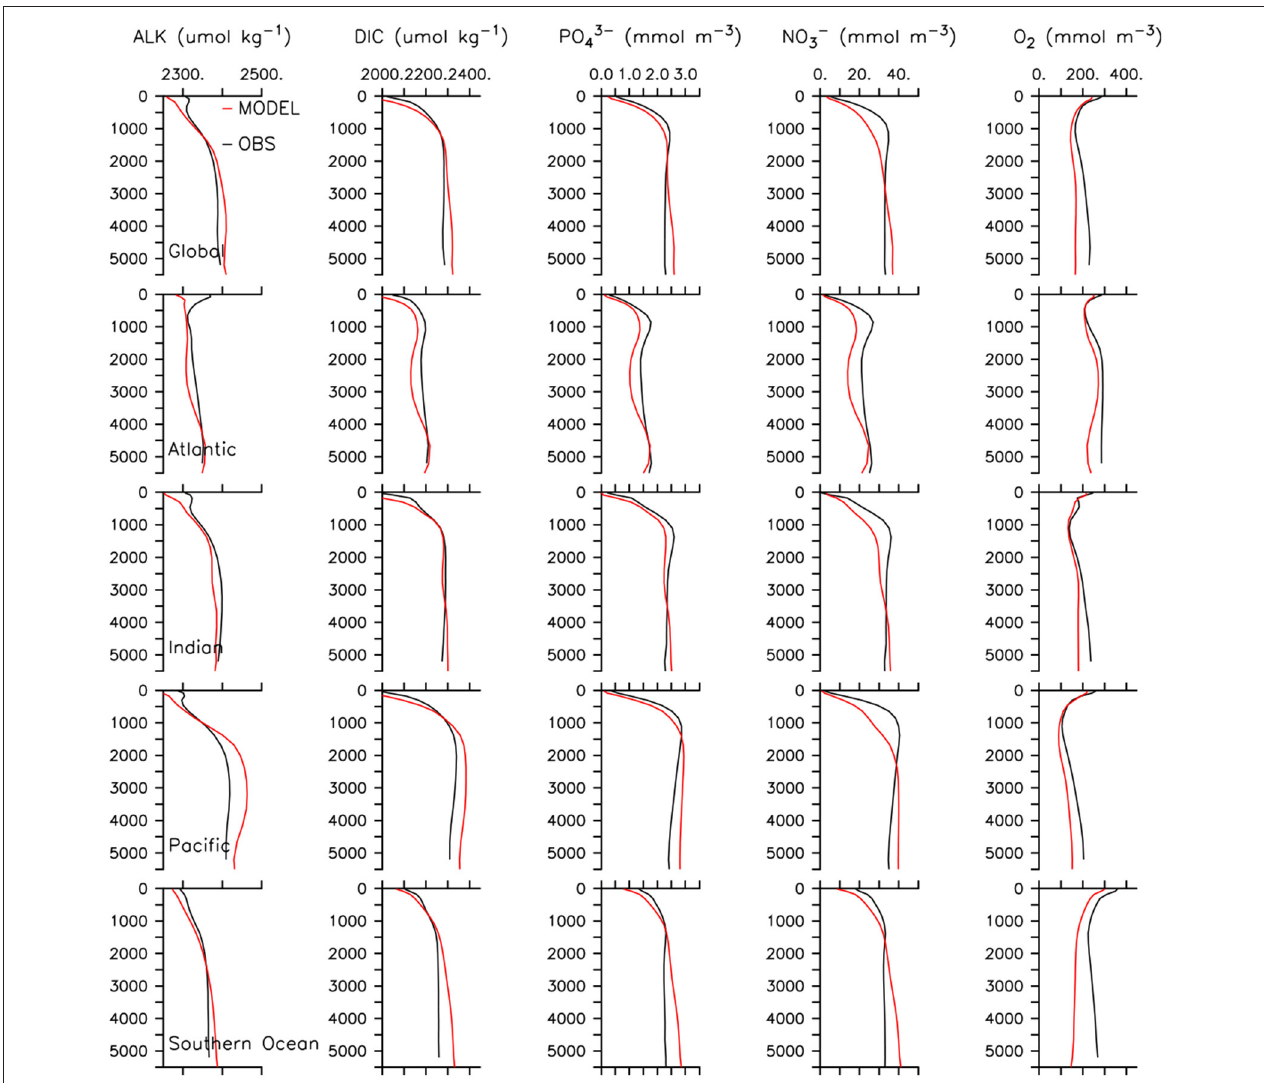
FIGURE 1 | Model global and basin-average profiles at year 2000 compared to WOA (Garcia et al., 2010a,b), and GLODAP (Key et al., 2004)